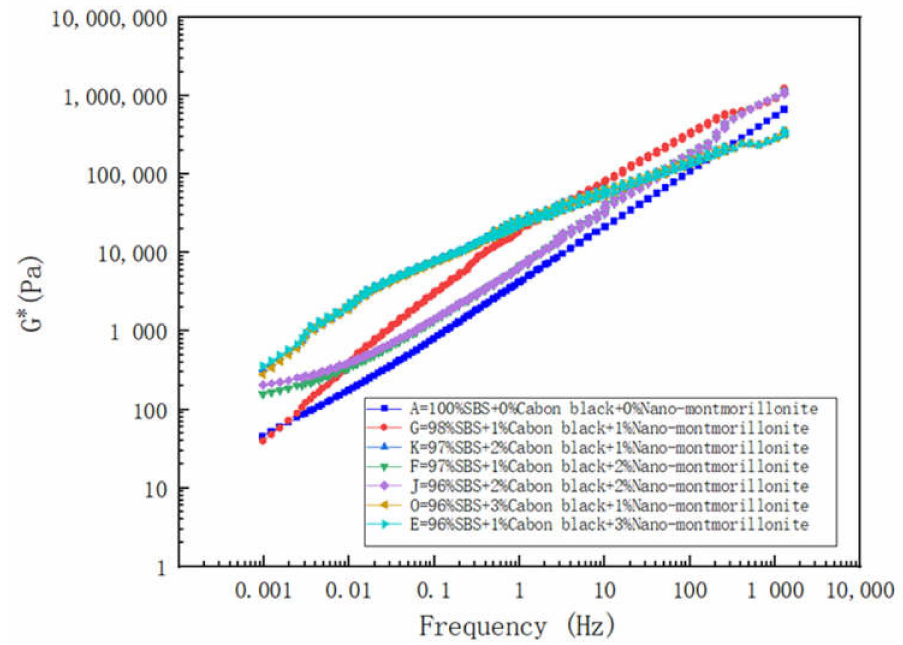
Figure 5. Main curves of the complex shear modulus of asphalt of different